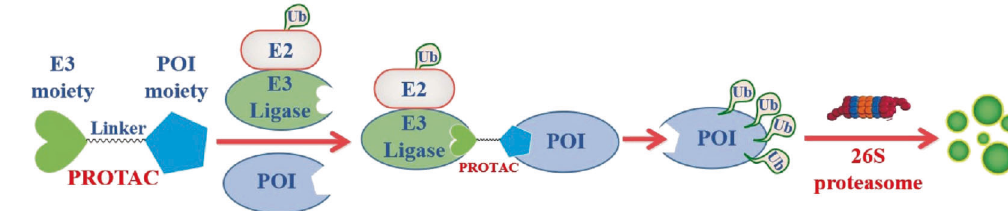
Fig. 1 The mechanism of PROTAC-mediated protein degradation